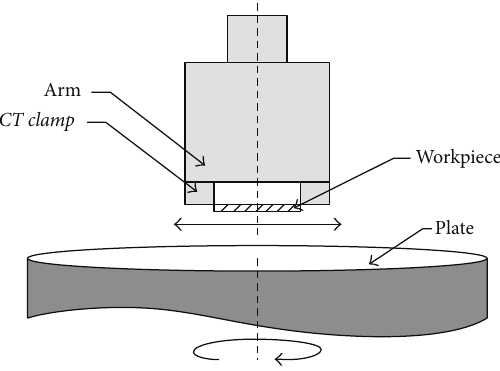
Figure 1: Schematic view of a lapping machine.